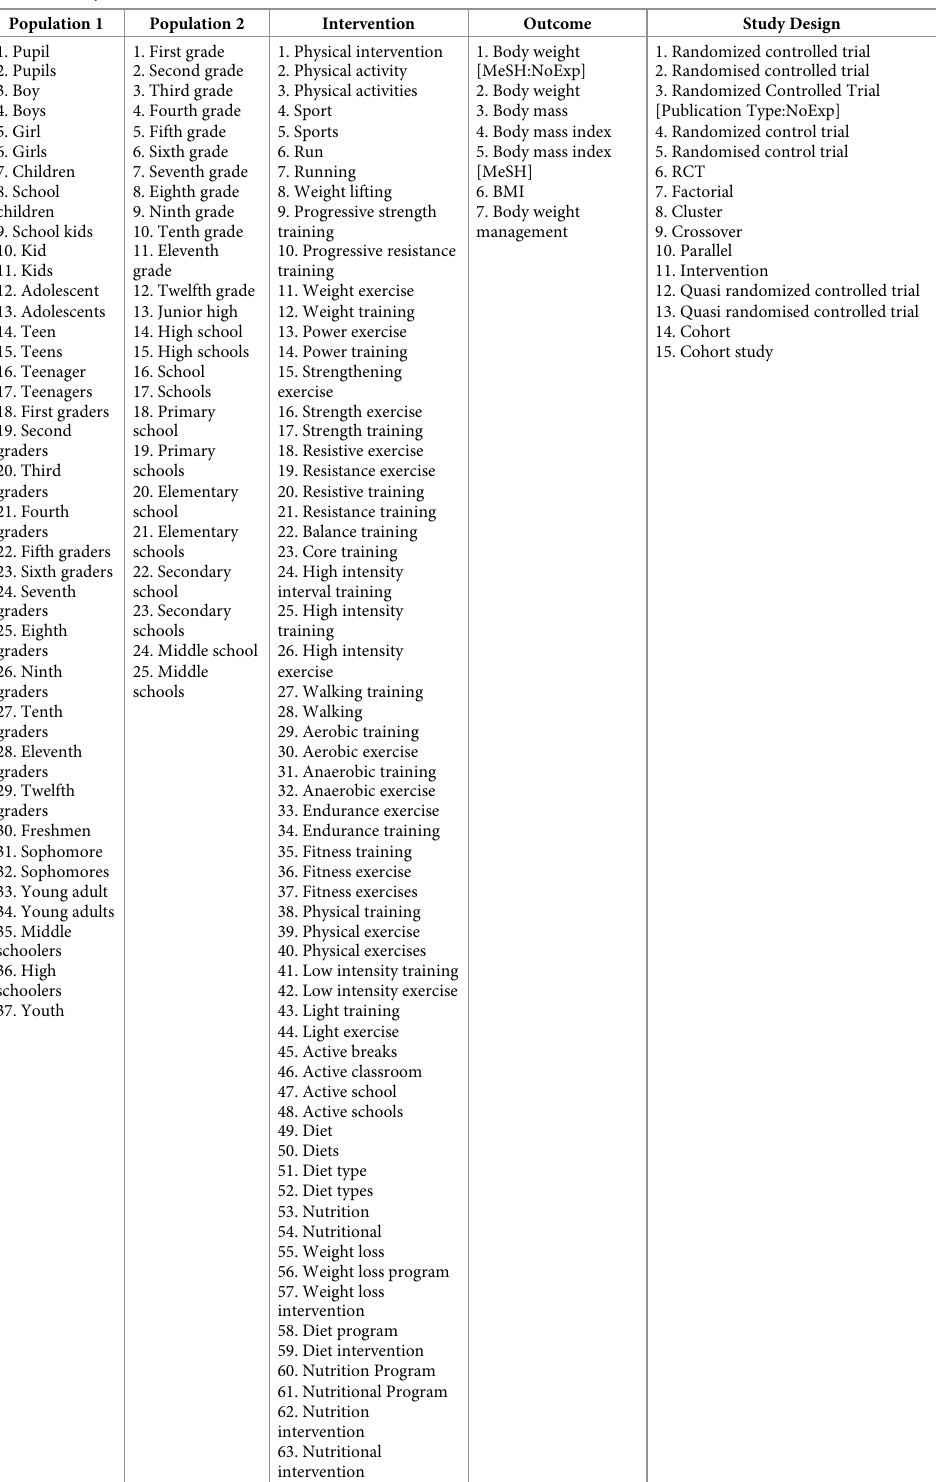
Table 1. Key terms for PubMed advanced